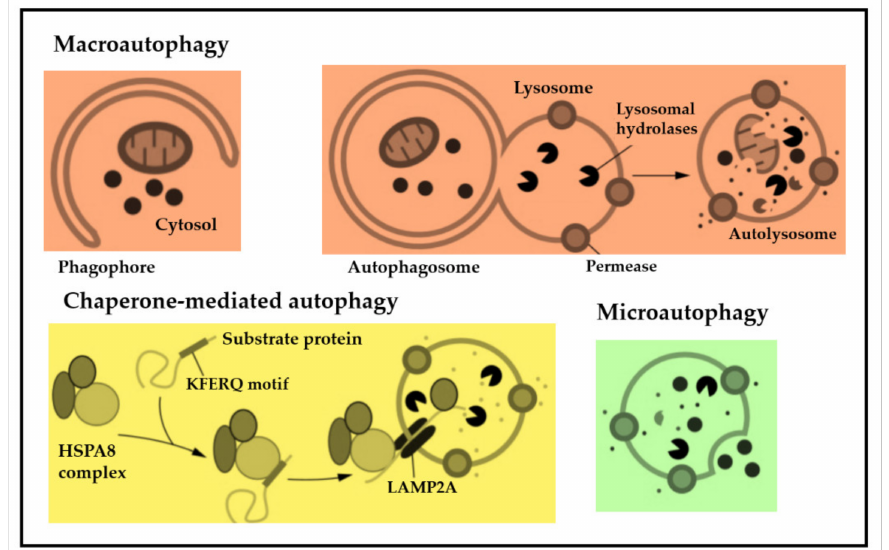
Figure 1. There are three types of autophagy in cells of mammals. In macroautophagy, double- membrane vesicles and autophagsosomes are created de novo in order to pack and transfer cell debris to the lysosome. In chaperone-mediated autophagy, misfolded proteins are carried individually across the lysosomal membrane. In microautophagy, cell detritus is taken up directly following the invagination of the lysosomal membrane. What all three autophagy modes have in common, is the complete breakdown of cell cargo and the secretion of degradation end products back into the cytosol for reuse. Figure adapted with kind permission from Parzych et al.